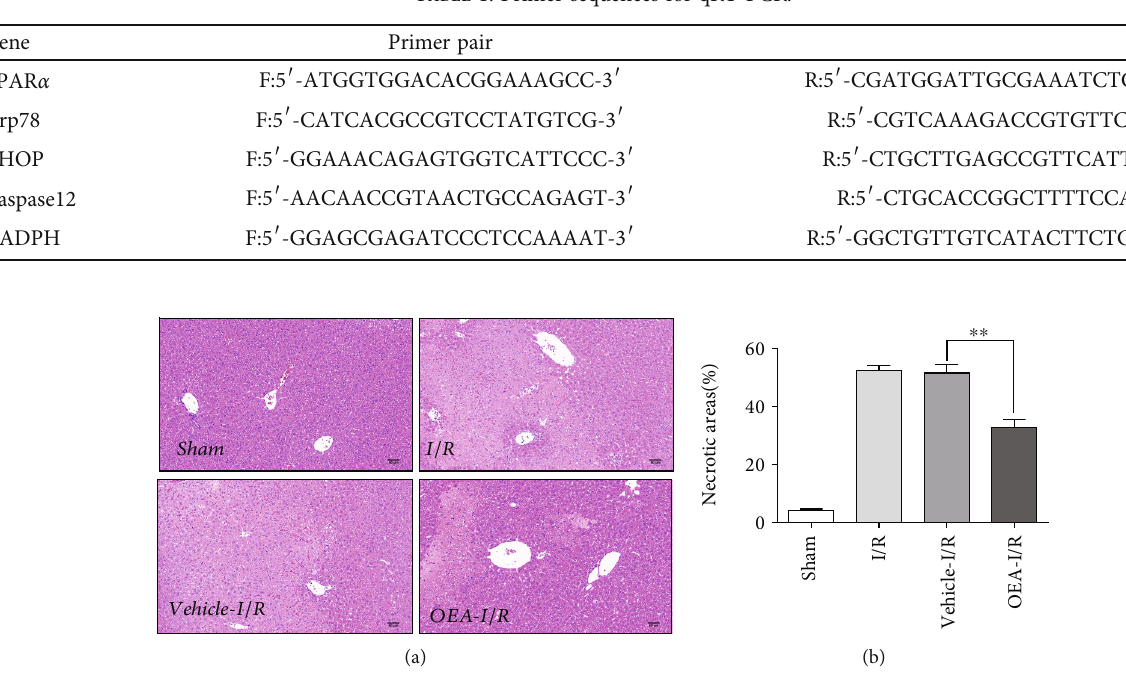
Table 1: Primer sequences for qRT-PCR.